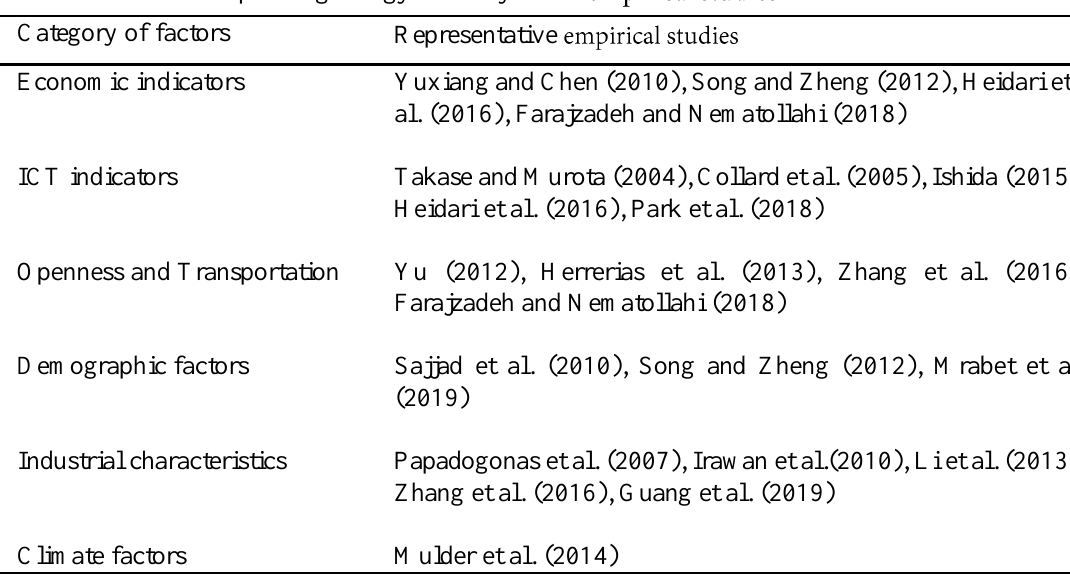
Table 1. Variables explaining energy intensity in the